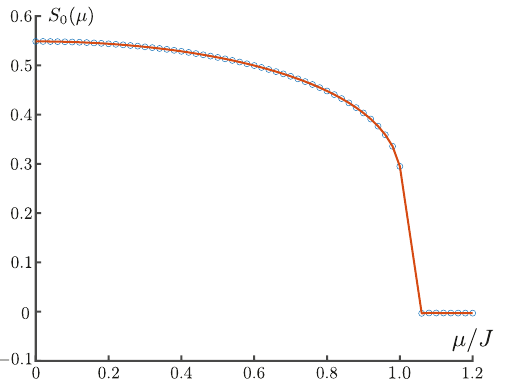
at various values of ψψ